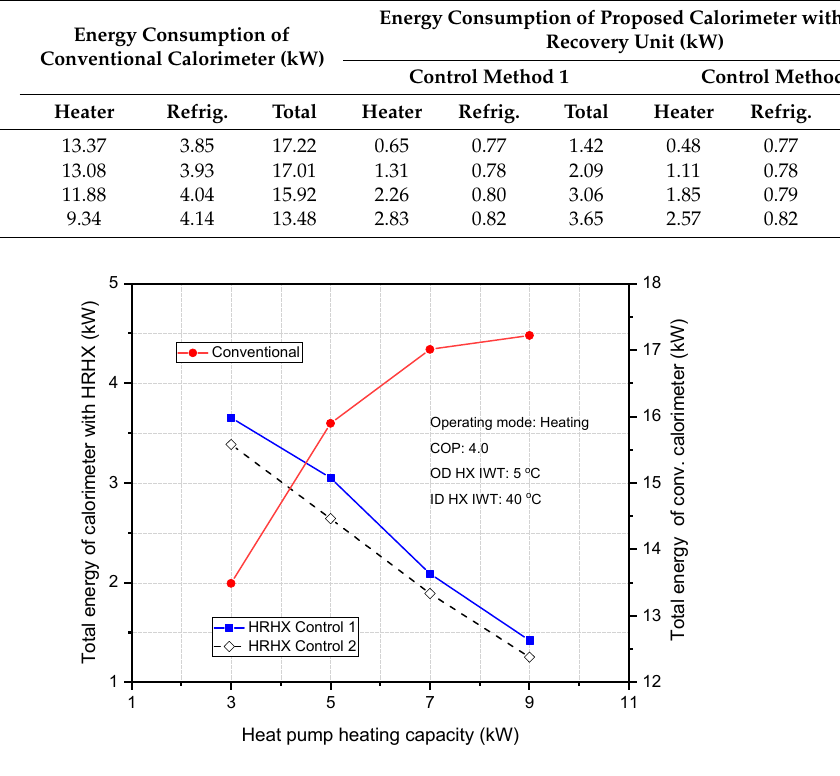
Figure 7. Total energy analysis for a conventional calorimeter and the heat recovery calorimeter in heating mode.